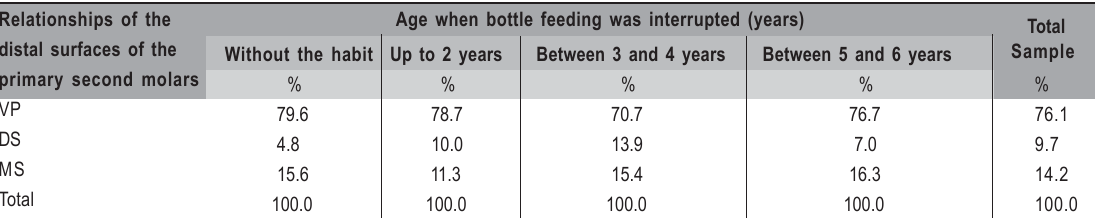
Vertical plane (VP), mesial step (MS) and distal step (DS). Table 2. Table 2. Table 2. Table 2. Table 2. Distribution of the relationships of the distal surfaces of the primary second molars according to the age when bottle feeding was interrupted.